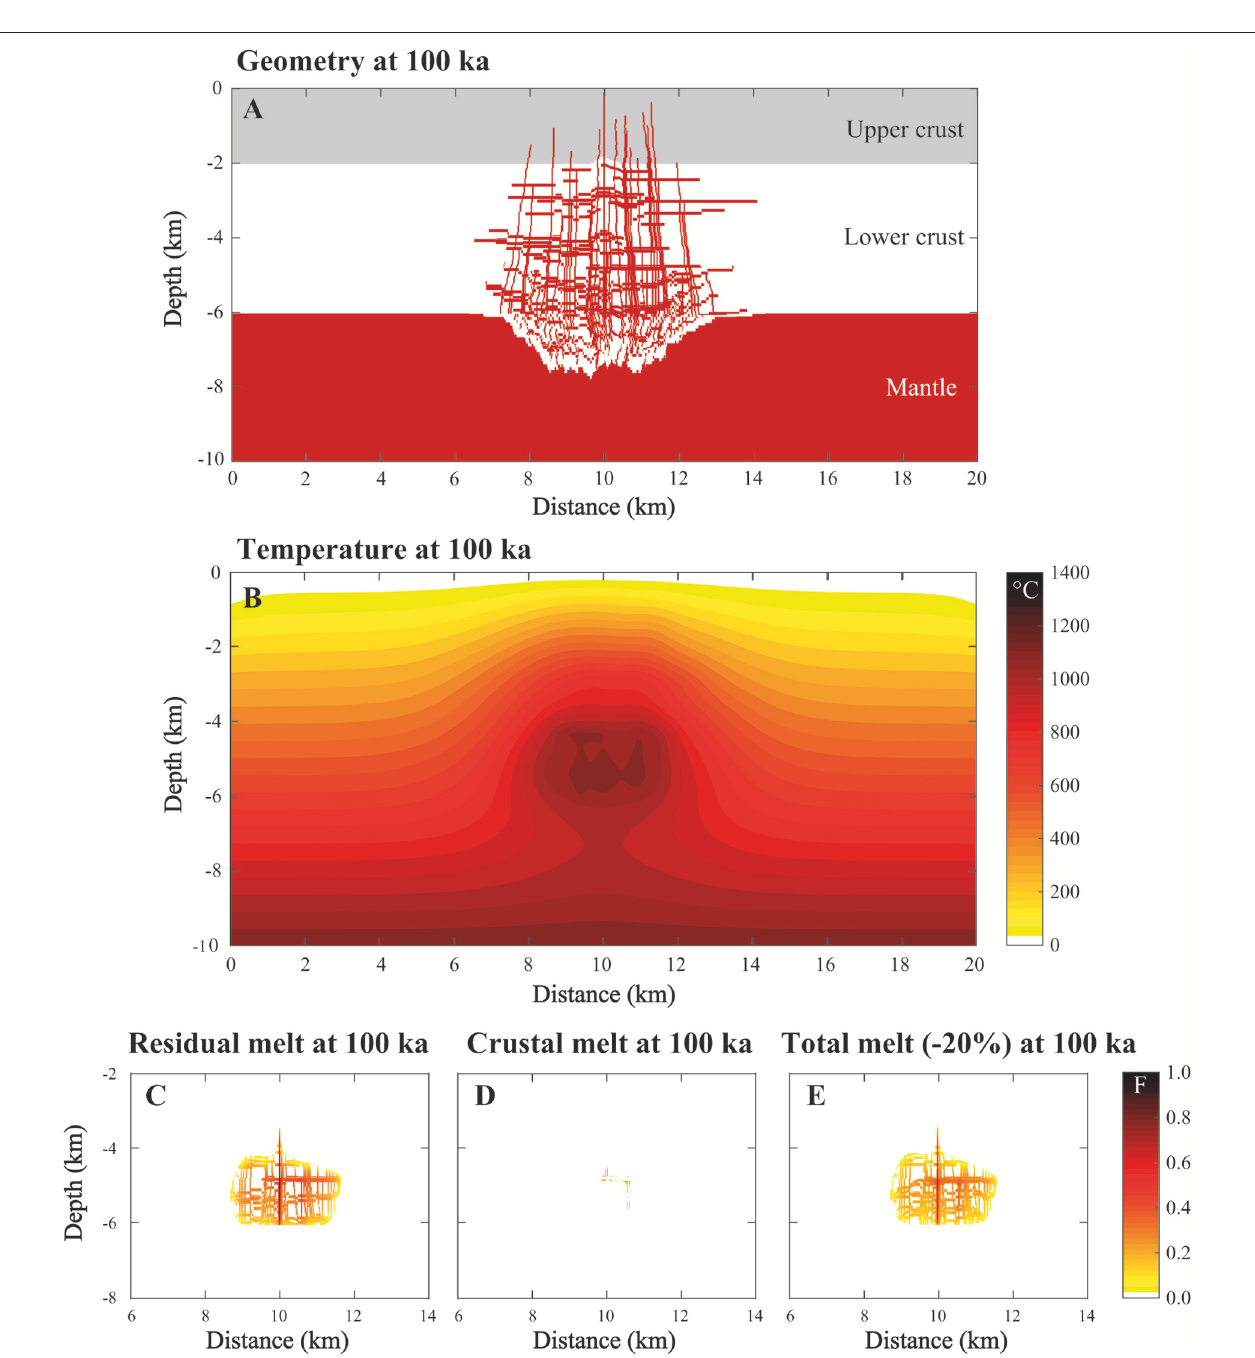
Figure 11 | Thermo-mechanical modeling of a slow-spreading ridge (spreading of 2 cm/year) (results for a similar model applied to fast-spreading ridges are shown in Figure A.4 ). (A) Dykes and sills intruded within the last 100 ′ 000 years (100 ka). (B) Thermal profile after 100 ka. It is very similar to the initial gradient, based on the Sinton and Detrick (1992) model. (C) Residual melt after cooling and crystallization of mantle-derived melt injected throughout the crust. (D) Crustal melt at 100 ka, localized next to dykes and sills. The occurrence of crustal melt is discontinuous in time. (E) Considering extraction of interstitial melt from the lower to the upper crust (estimated here to be ca. 20%), the total melt fraction is generally less than ca. 20%.